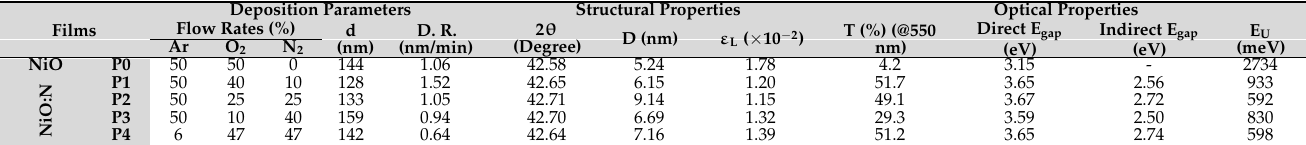
Table 2. Details of sputtering conditions and properties of undoped and N-doped NiO films. D = thickness, D.R. = Deposition Rate, 2 θ = 2 Theta (degree) position of (200) diffraction peak, D = crystallite size, ε L = lattice strain, T = transmittance, Egap = energy gap, E U = Urbach